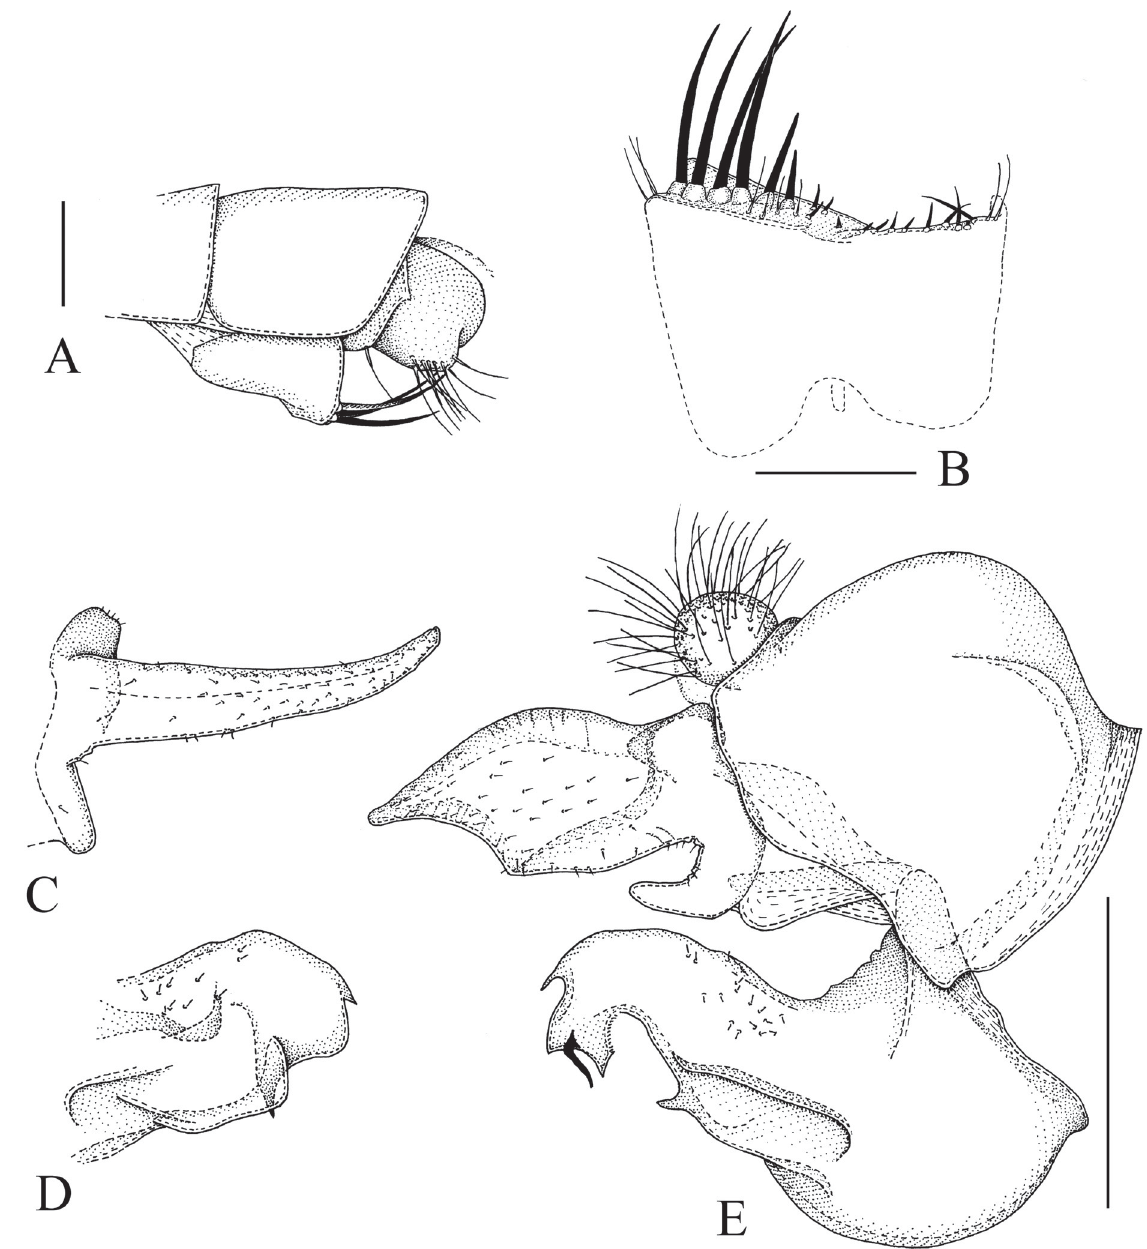
Fig. 37. Sphegina (Asiosphegina) gigantea sp. nov., holotype, ♂ . A . Posterior part of abdomen, left side lateral view. B . Sternum I V, ventral view. C . Left surstylus, lateral view. D . Left superior lobe, lateral view. E . Genitalia, right side, lateral view. Scale bars = 0.5